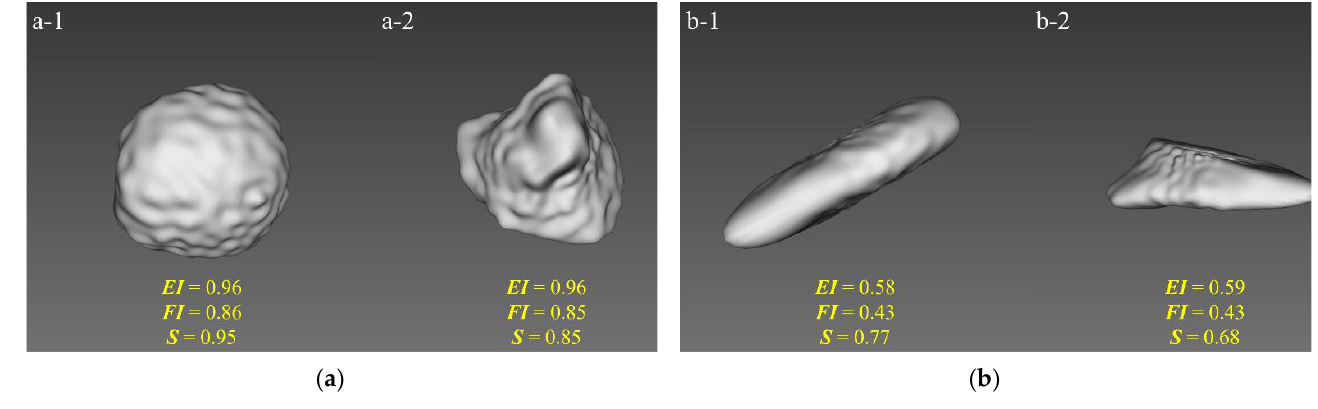
Figure 15. Comparison of two pair of desert sand particles with close aspect ratios and different sphericity: ( a ) Group 1; ( b ) Group 2. Table 2. Average values of size indexes and shape descriptors of desert sand particles with different